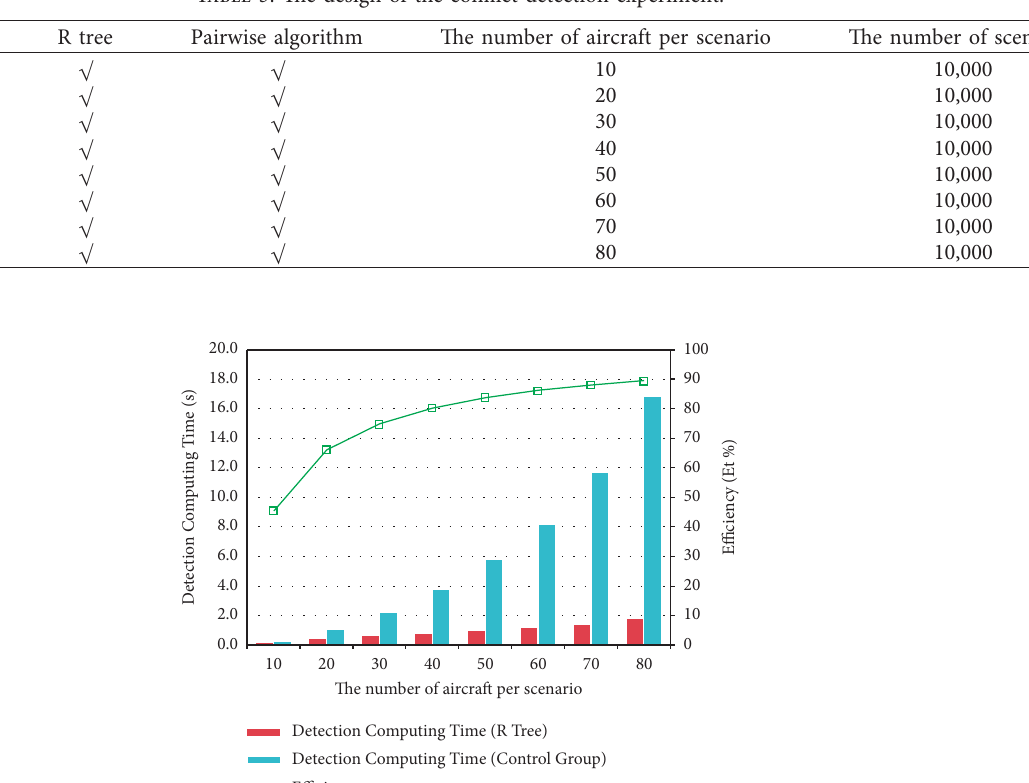
Table 3: The design of the conflict detection experiment.